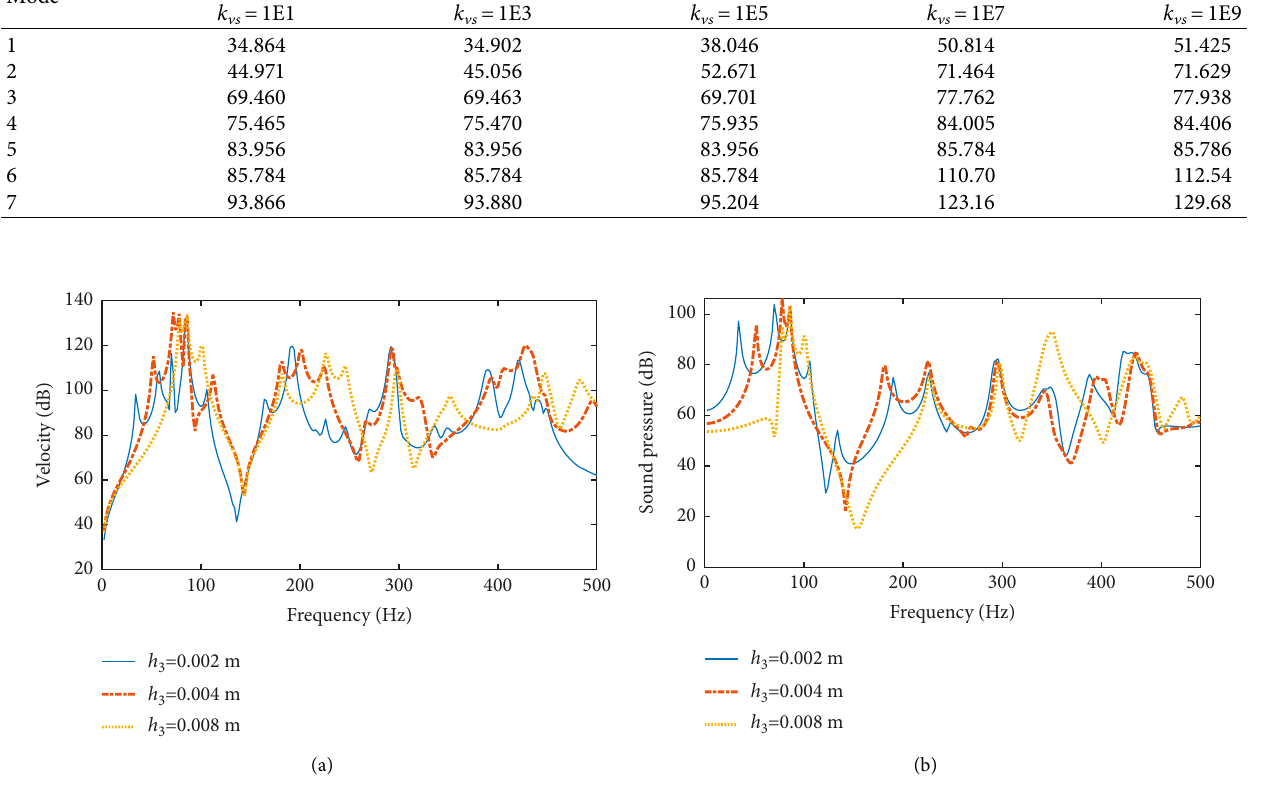
Table 5: First eight natural frequencies of the stiffened double panel-cavity coupled system with the boundary springs of the stiffener. Mode